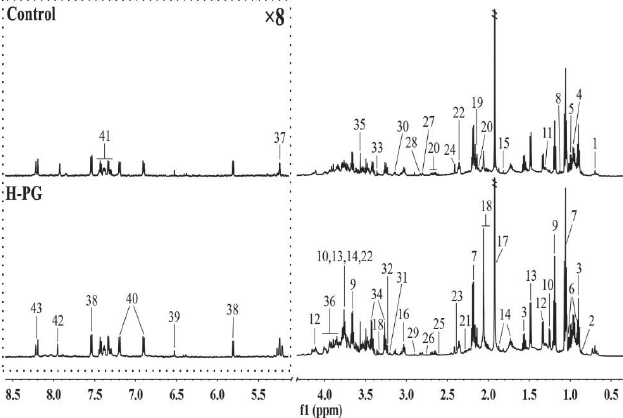
FIGURE 3 - 1 H-NMR spectra of the feces metabolites from the control group and PG group. TABLE I - 1 H-NMR signal assignments for the metabolites in the feces contents